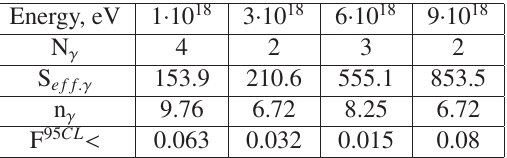
Table 2. Predicted number of showers produced by primary